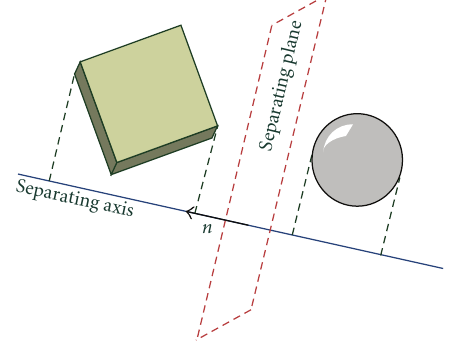
Figure 6: Principles of the intersection test between an OBB and a